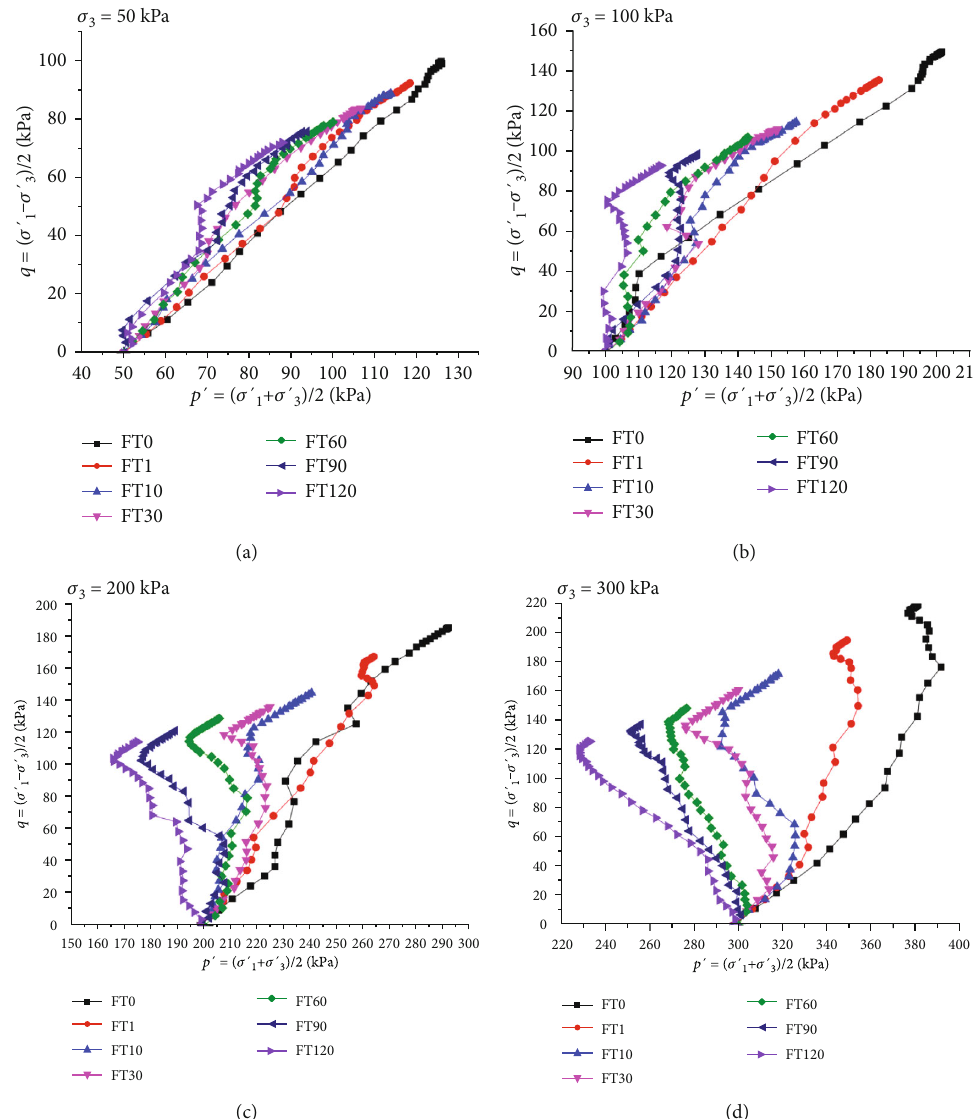
Figure 7: E ff ective stress path of specimens in the undrained shear test after freeze-thaw